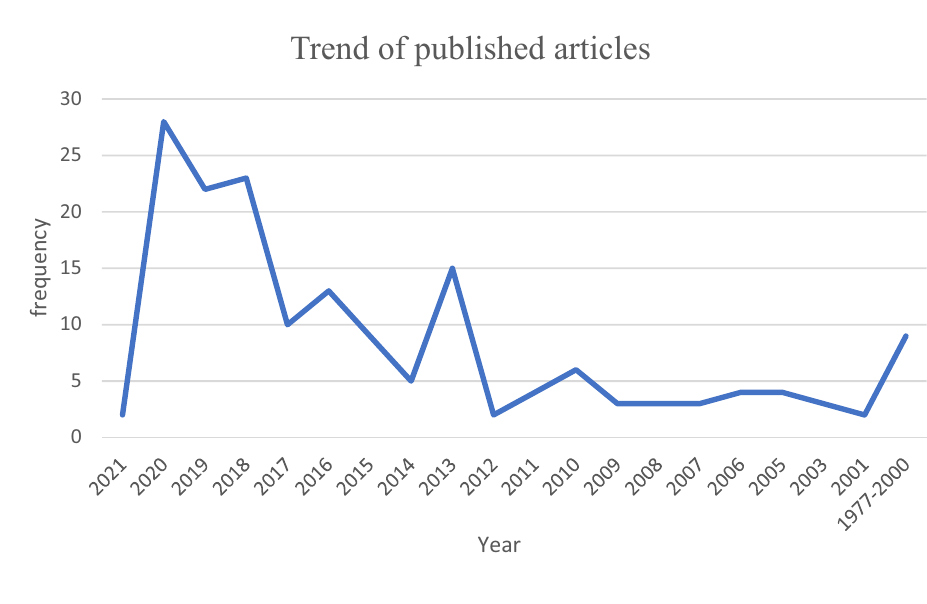
Fig. 3 Summary of studies by publication years